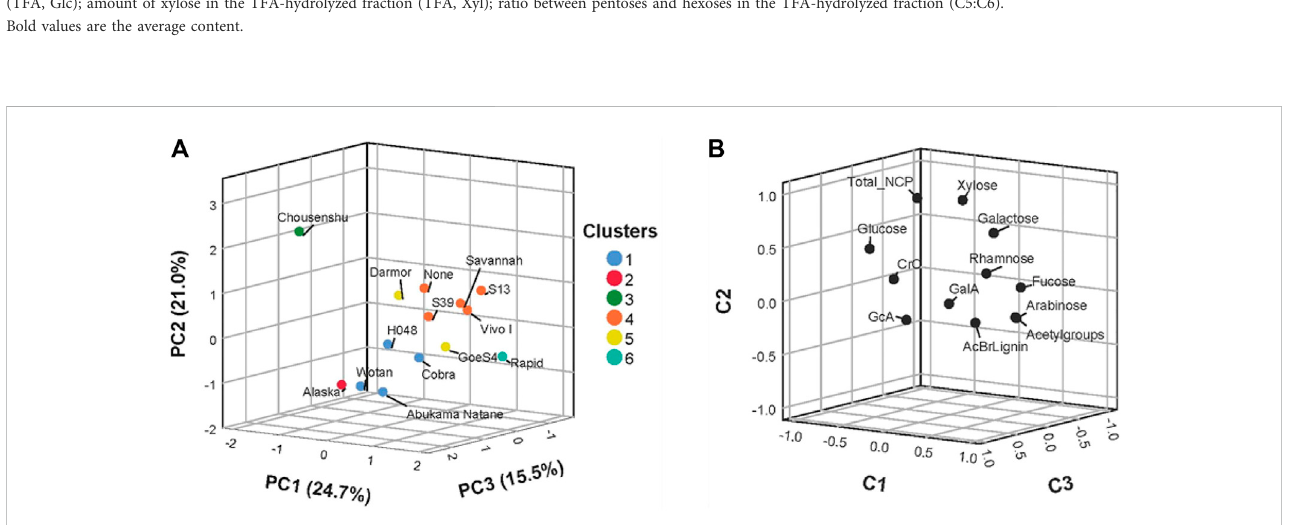
FIGURE 3 Discriminantanalysisofthedifferentrapeseedaccessions. (A) Scoresplotonthe fi rstthreecomponents. (B) Loadingsplotonthe fi rstthreecomponents. Principle component analysis was performed with 12 variables (normalized data of mean values) measured in nine replicates for each